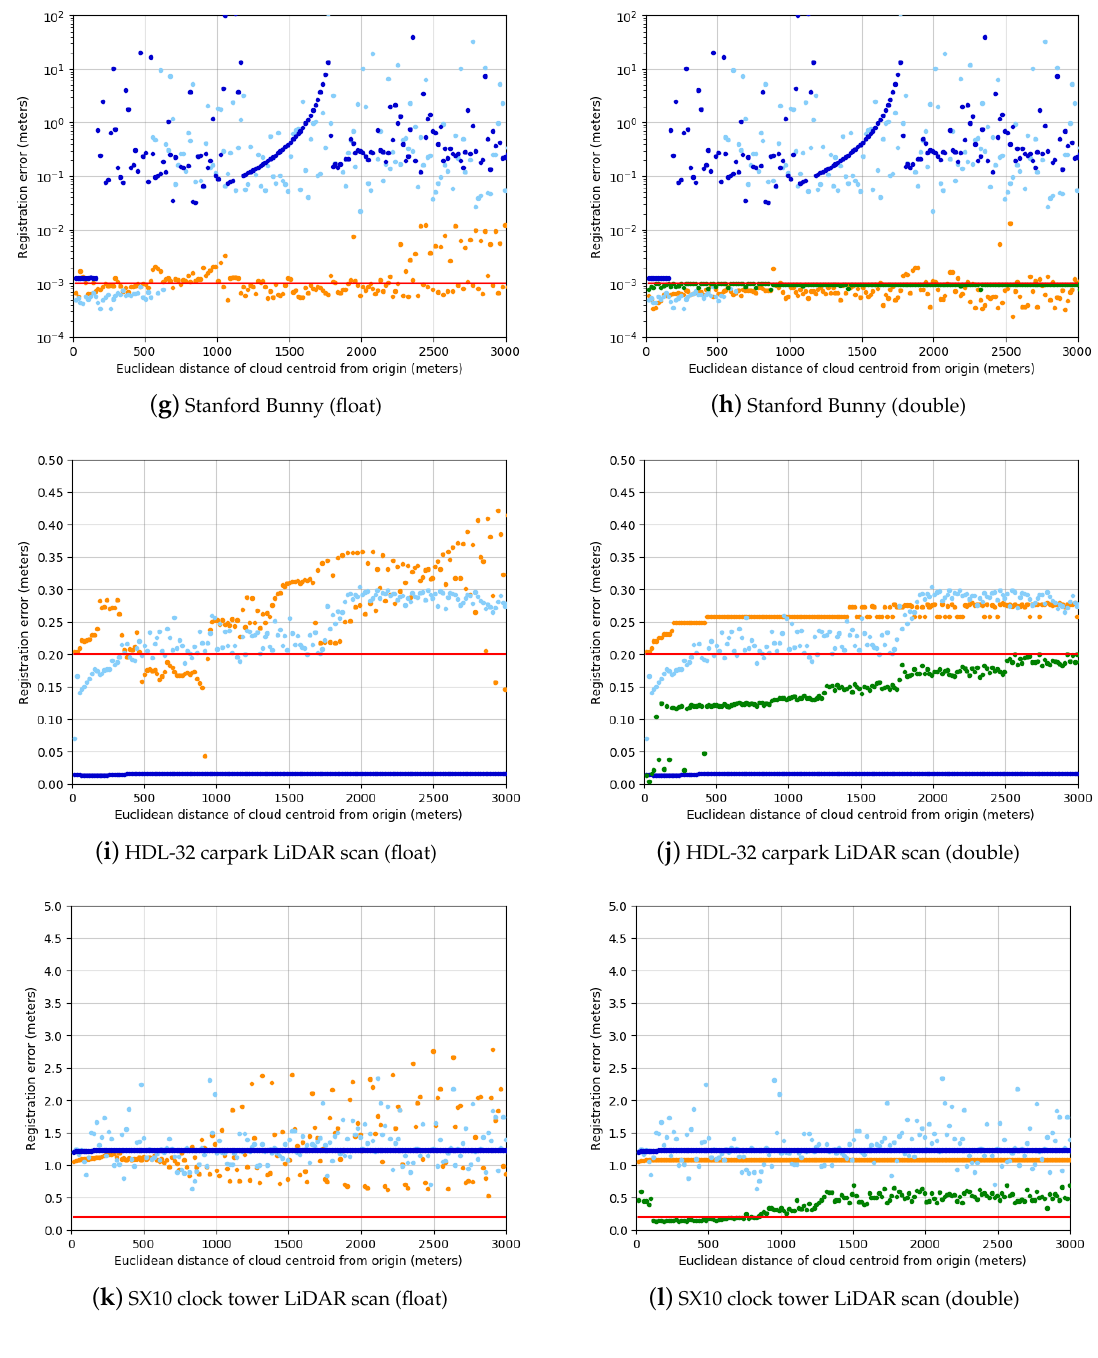
Figure 6. Registration point-to-point error. Each plot point represents the calculated result of a single cloud point. Plots on the left were generated with the float data type, images on the right with the double data